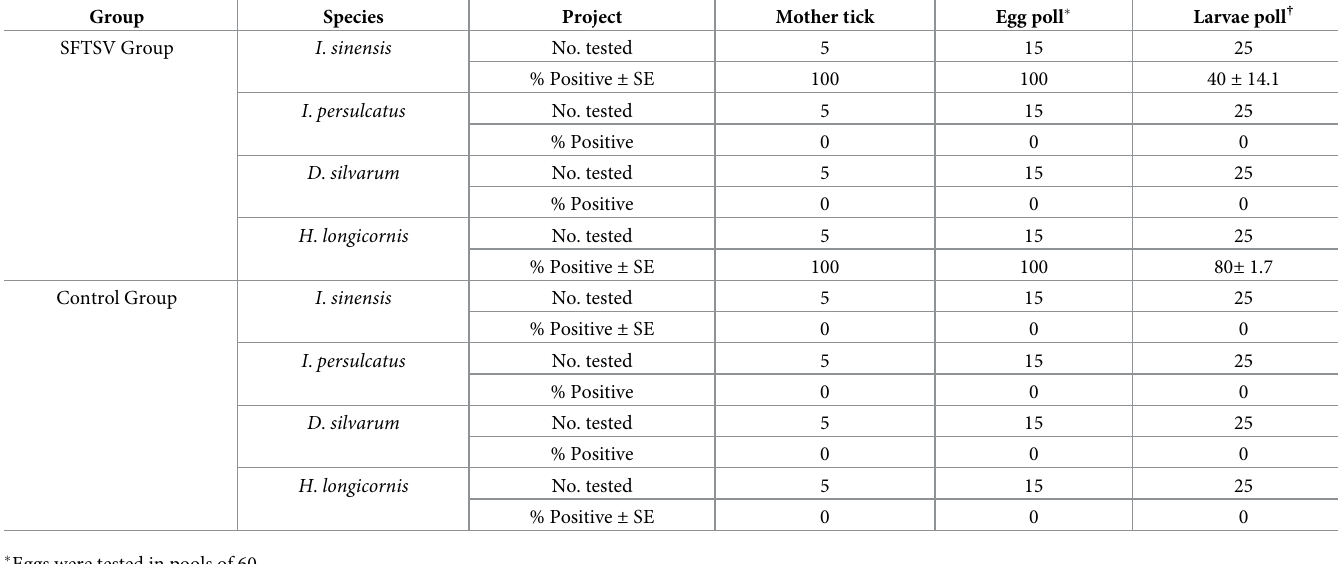
� Eggs were tested in pools of 60. †Larvae were tested in pools of